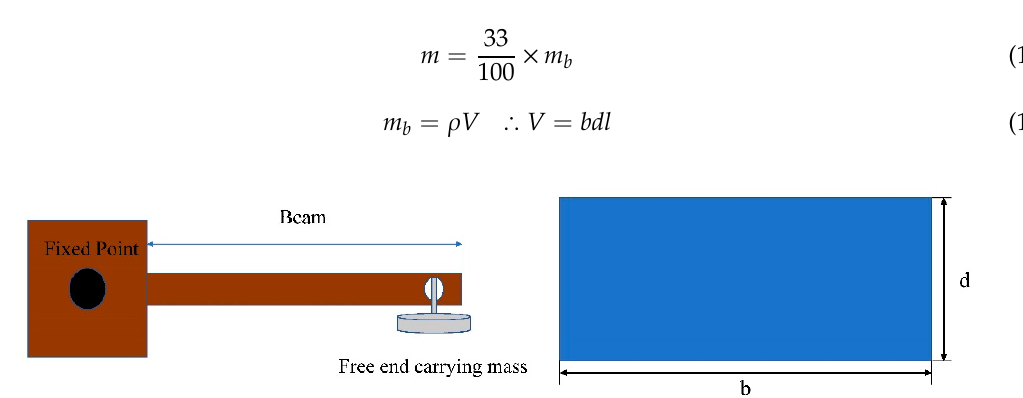
Figure 19. Cantilever beam with attached mass (bobbin) with free vibration (lumped mass) ( left ) and rectangular cross-section of the beam ( right ).